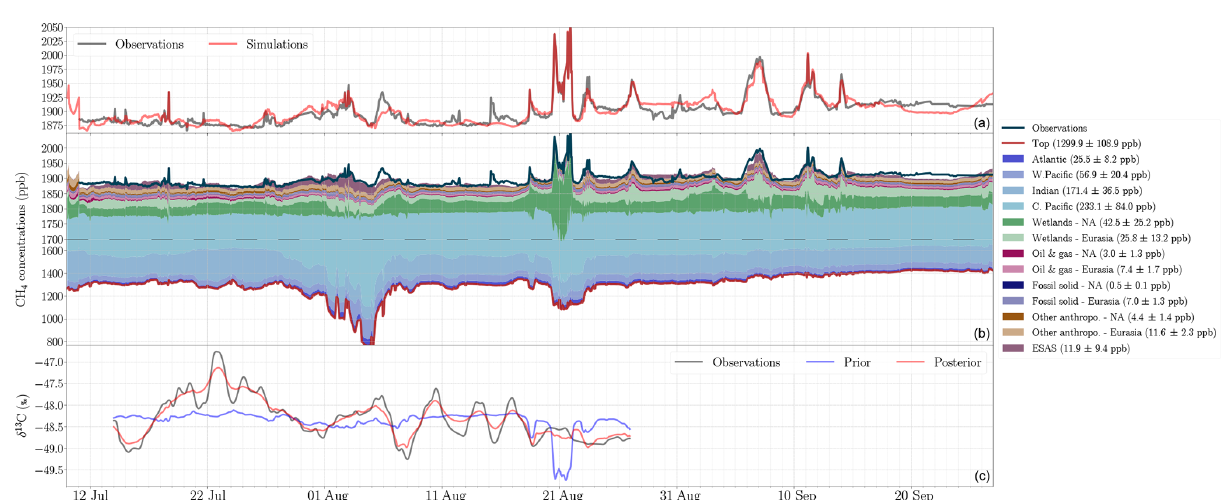
Figure 2. (a) Observed and simulated total CH 4 concentrations. (b) Simulated contributions to total CH 4 concentrations. Individual regions simulated by the model (see Fig. 1) are aggregated into two main continental components: North America (NA) and Eurasia. Light green areas depict Eurasian (mostly Siberian) wetlands, while dark green ones are North American wetlands. Shaded blue areas represent contributions from the sides of the CHIMERE simulation domain (see Fig. 1). Orange shades represent minor anthropogenic contribution. So-called “top” line gives the simulated concentrations originating from the lower stratosphere (i.e. from the top of CHIMERE simulation domain). Please note the gap in y axis scale at 1700ppb, highlighted by the dashed line. (c) Observed and simulated isotopic ratios before (prior) and after (posterior)